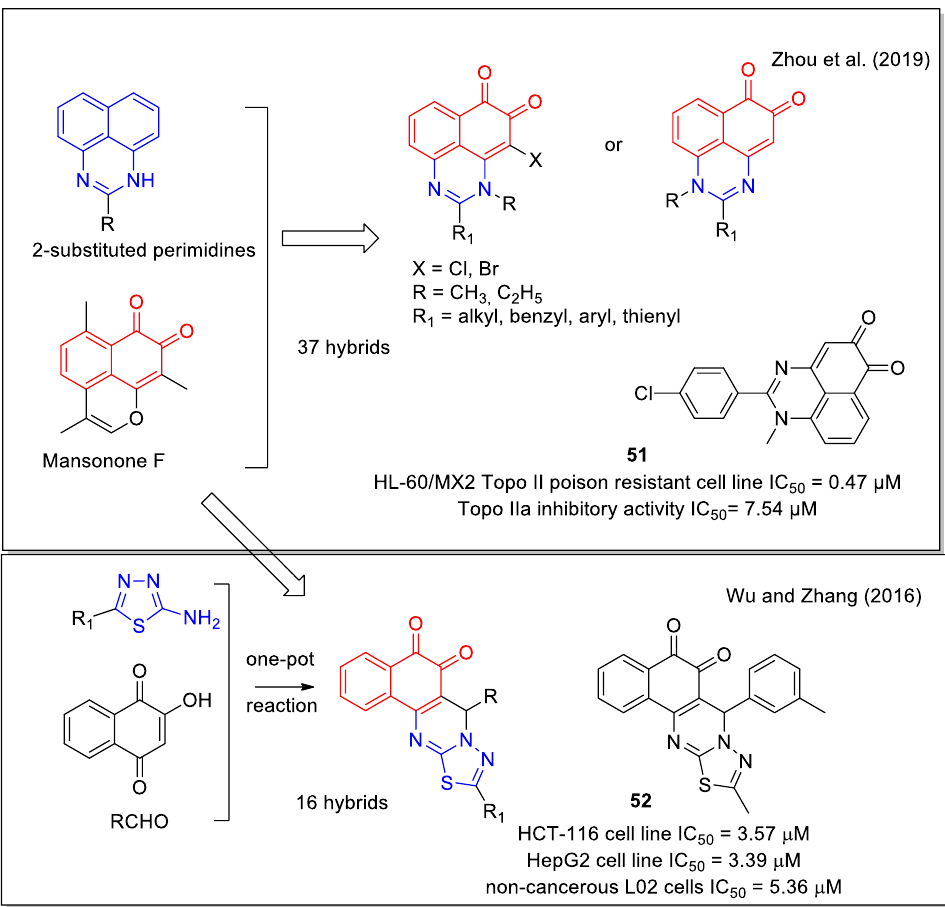
Figure 21. 1,2-Naphthoquinone hybrids containing the 2-substituted pyrimidine scaffold as re- ported by Zhou et al. [61] and the 1,3,4-thiadiazolo [3,2- a ]pyrimidine scaffold by Wu and Zhang